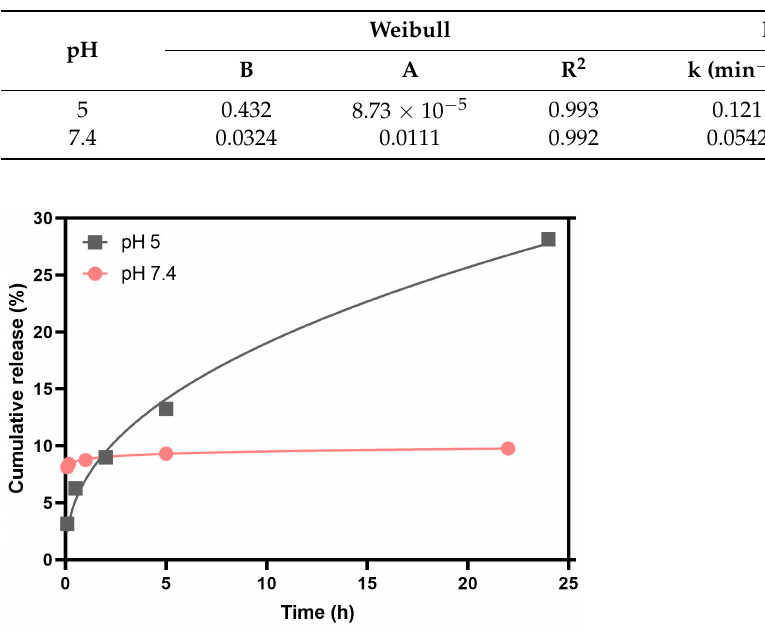
Table 7. Parameters obtained by fitting the mathematical models to the release kinetics of doxorubicin encapsulated in SMLs (Weibull and first-order) and respective coefficients of determination (R 2 ) for each pH value studied (5 and 7.4).